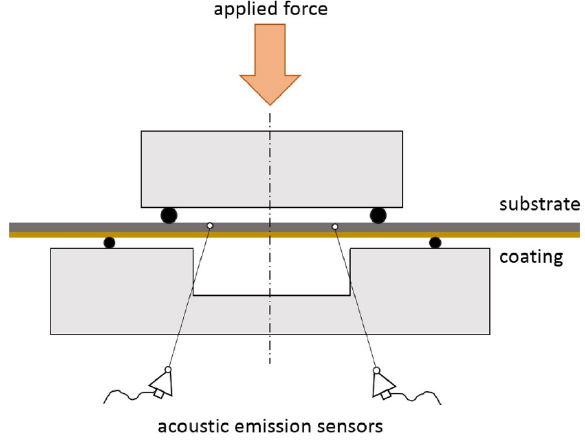
Figure 6: Schematic representation of the four-point bending test (based on